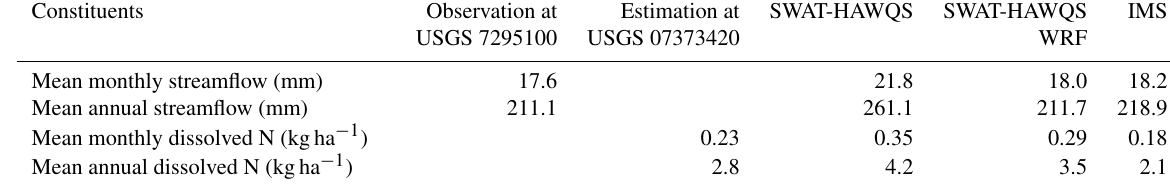
Table 4. Model evaluation for monthly and annual streamflow (mm) and dissolved N (kgha − 1 ) for the simulation period 2002–2010. Constituents Observation at Estimation at SWAT-HAWQS